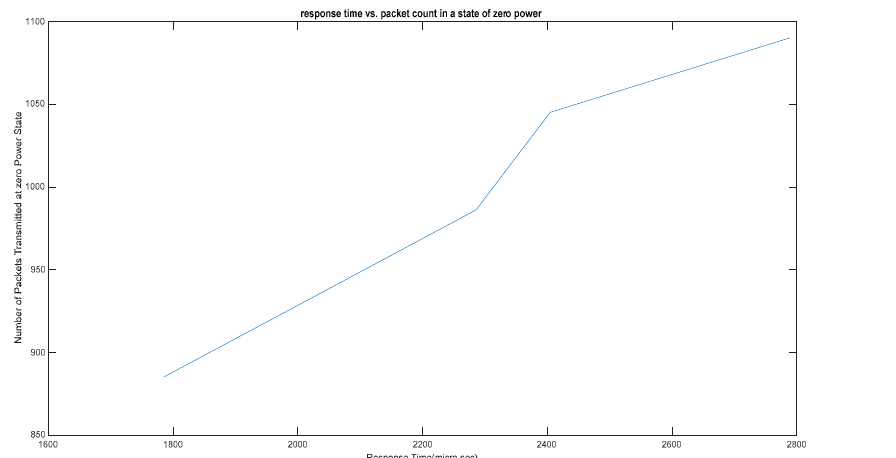
Figure 3. Response time as a function of data volume.